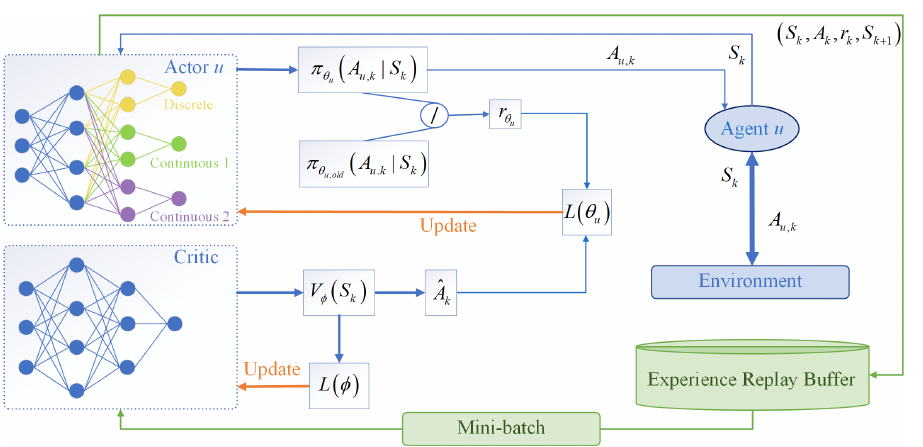
Figure 2. The MAHPPO algorithm structure of agent u